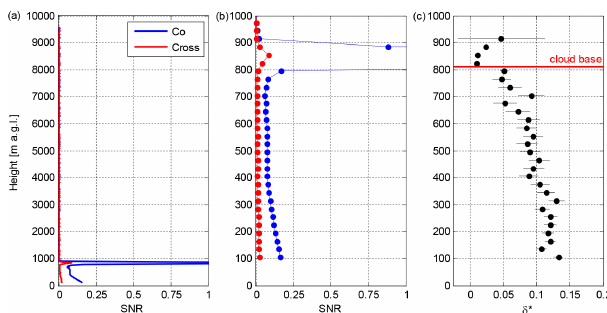
Figure 2. Profiles at Limassol, Cyprus, on 2 May 2017 at 12:08UTC. (a) Co- and cross-polar SNR. A liquid cloud at ap- prox. 800ma.g.l. results in full attenuation of signal. Below cloud layer aerosol signal is visible. Above 1km variability in SNR is due to instrumental noise only. (b) The same as panel (a) but limited to lowest 1kma.g.l. (c) Ratio of cross-polar SNR to co-polar SNR up to 1kma.g.l. calculated from profiles in panel (a) . Error bars rep- resent uncertainty due to instrumental noise estimated from SNR at > 1kma.g.l. in panel (a)